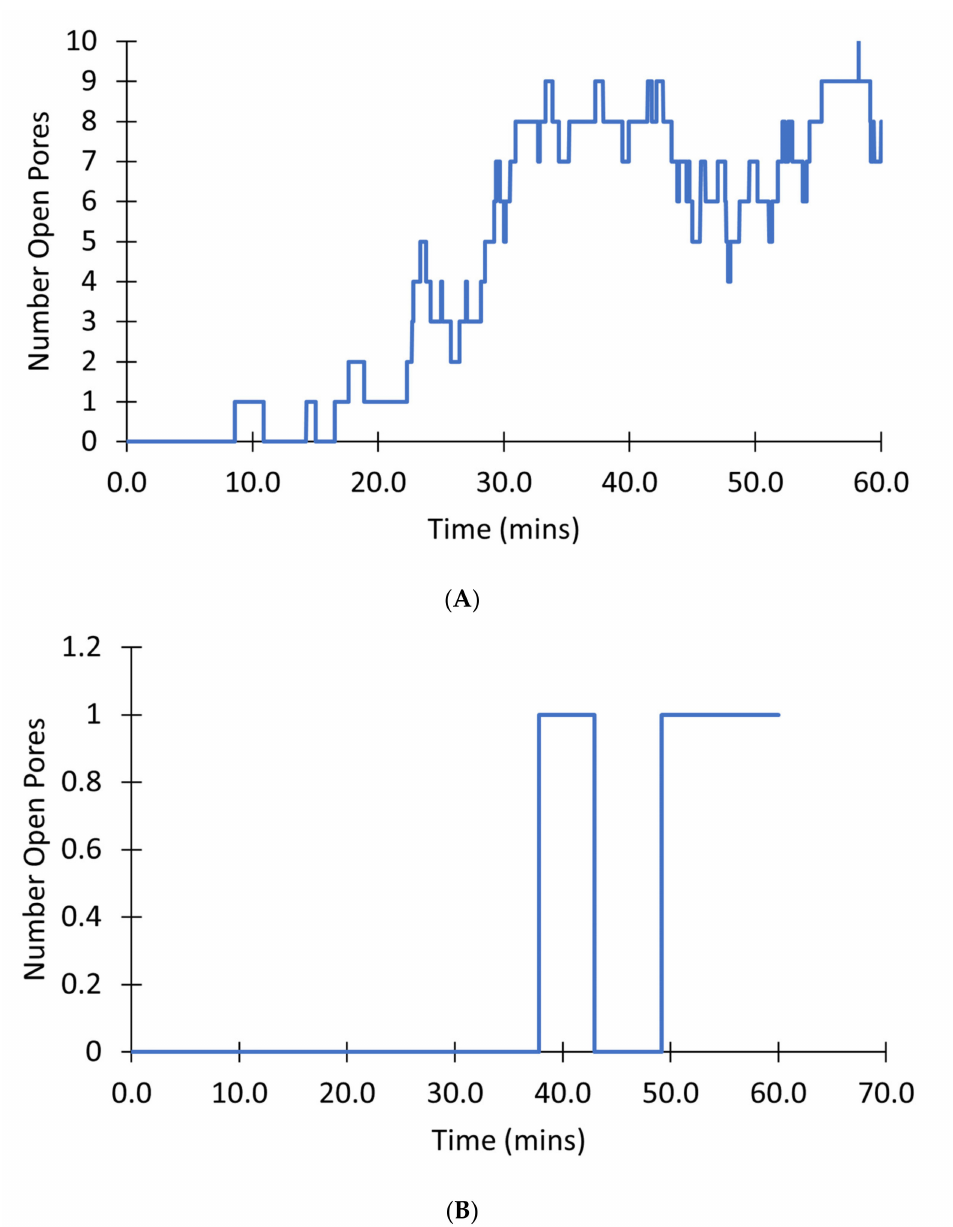
Figure 13. Simulation of a mitochondrion mPTP with only transient states. ( A ) Number of pores in the transient open state in a mitochondrion with 10 pores. ( B ) Number of open pores in the transient open state in a mitochondrion with 1